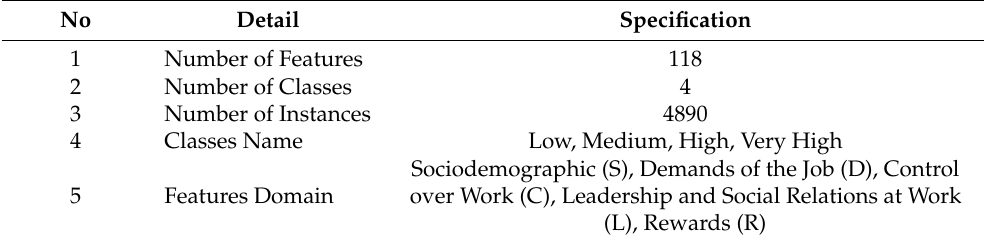
Table 1. Detailed specification of